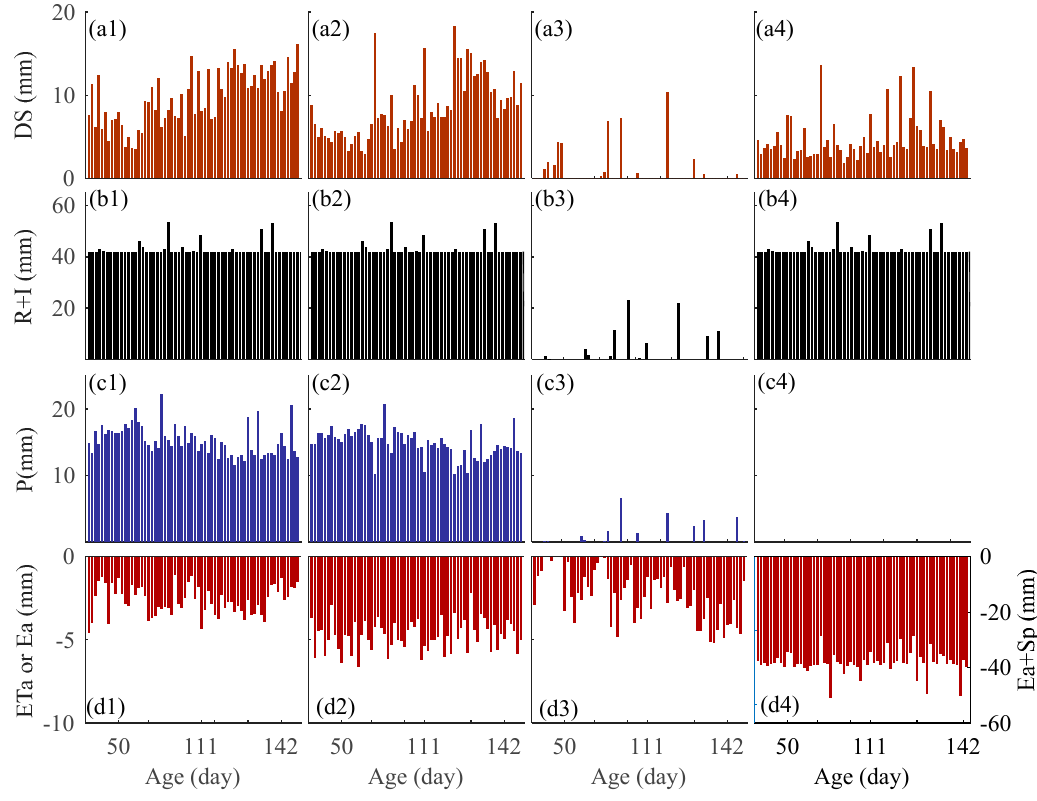
Figure 4. Water balance components in the different treatments (where 1–4 represent T1–T4, respectively) from 07:30 h to 16:00 h on day 40–142 of Eucalyptus pellita growth: ( a1–a4 ) change in soil water storage (DS), ( b1–b4 ) rainfall (R) plus irrigation (I), ( c1–c4 ) percolation (P) and ( d1–d4) evapotranspiration (ET a ) or evaporation (E a